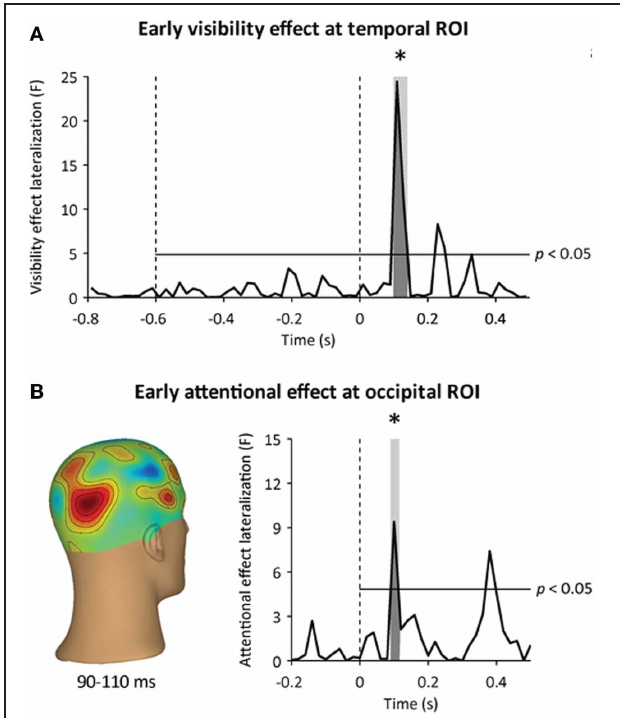
FIGURE 6 | Time courses of awareness- and attention-dependent effects. (A) Time course of the awareness-dependent effect at the temporal ROI. The visibility effect lateralization corresponds to the lateralization of the awareness-dependent effect (hits minus misses) in the event-related MEG response to visual stimulation at the temporal ROI, expressed in F units. The earliest significant awareness-dependent effect occurred at 110–130 ms following target onset. (B) Time course of the attention-dependent effect at the occipital ROI. Left: three-dimensional topography of the early attention-dependent effect (valid minus invalid targets) at 90–110ms following target onset. Right: the attentional effect lateralization corresponds to the lateralization of the attention-dependent effect (valid minus invalid targets) in the event-related MEG response to visual stimulation at the occipital ROI, expressed in F units. The earliest significant attention-dependent effect occurred at 90–110ms following target onset. Horizontal lines indicate an uncorrected statistical threshold at p < 0 . 05. Stars indicate significant awareness- and attention-dependent effects ( p < 0 .